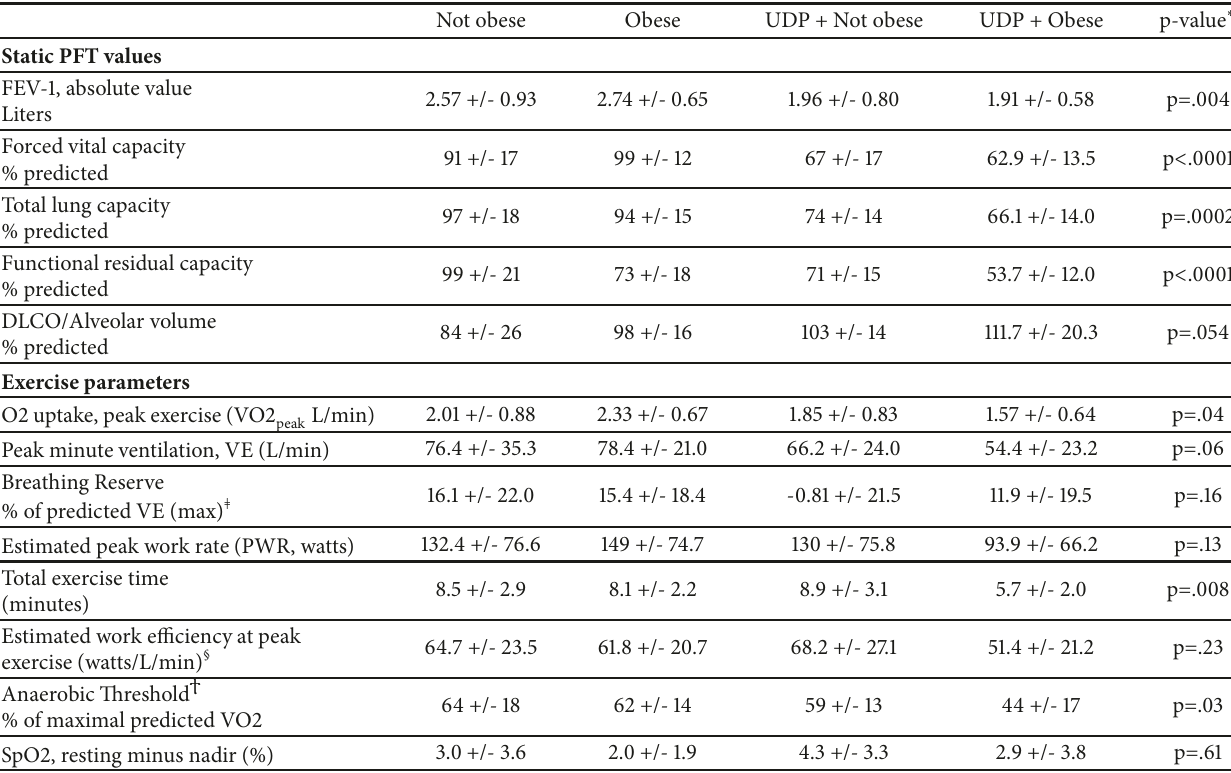
Table 2: Effect of UDP, obesity, and their combination on static PFTs and exercise